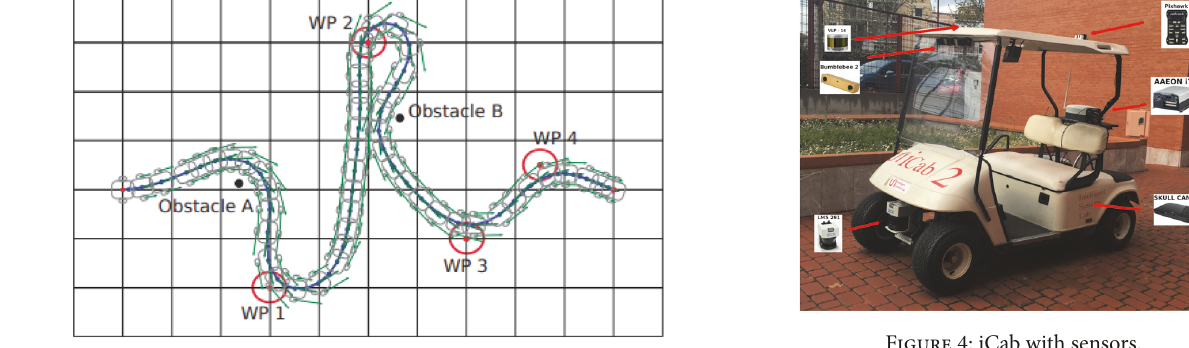
Figure 2: Description of Time Elastic Bands from [15].